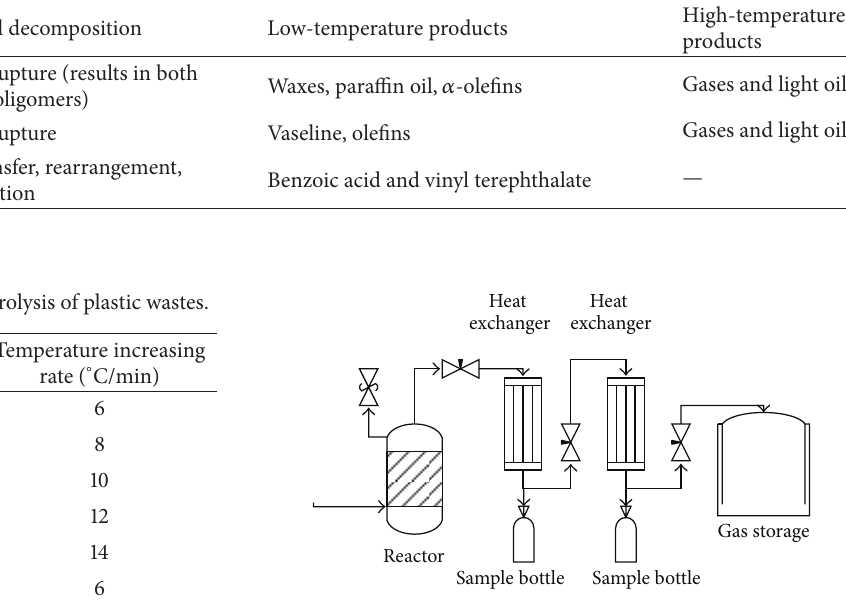
Figure 1: The schematic diagram of pyrolysis